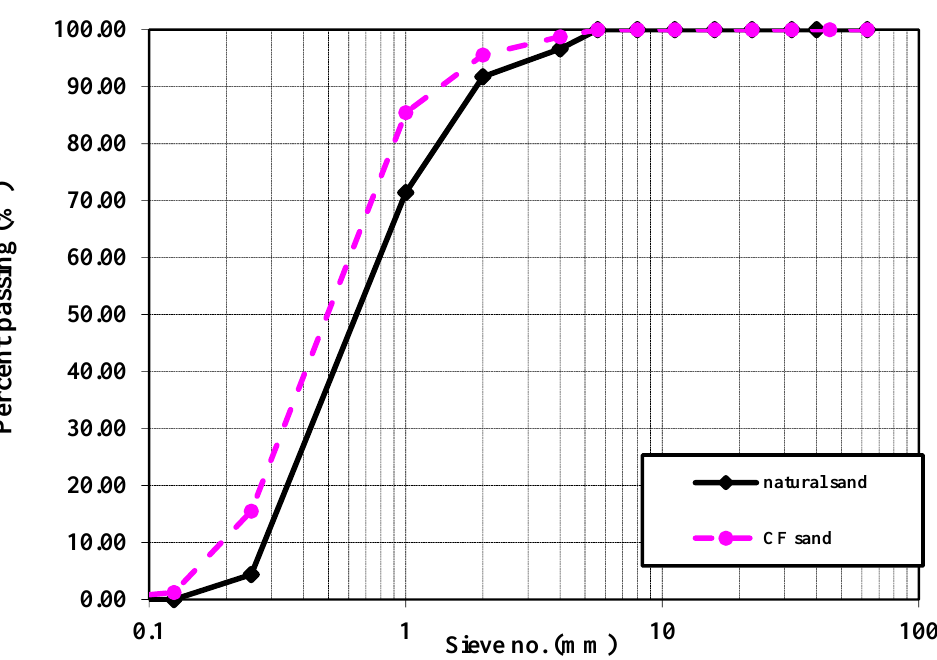
Figure 1. Passing percentage of aggregates utilized (natural and CF sand).